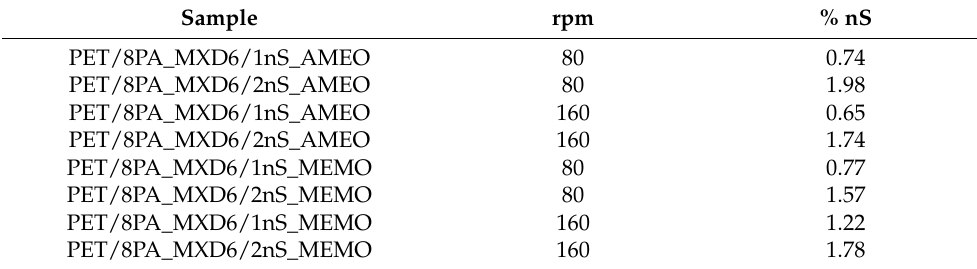
Table 2. Percentage of nanosepiolite present in the